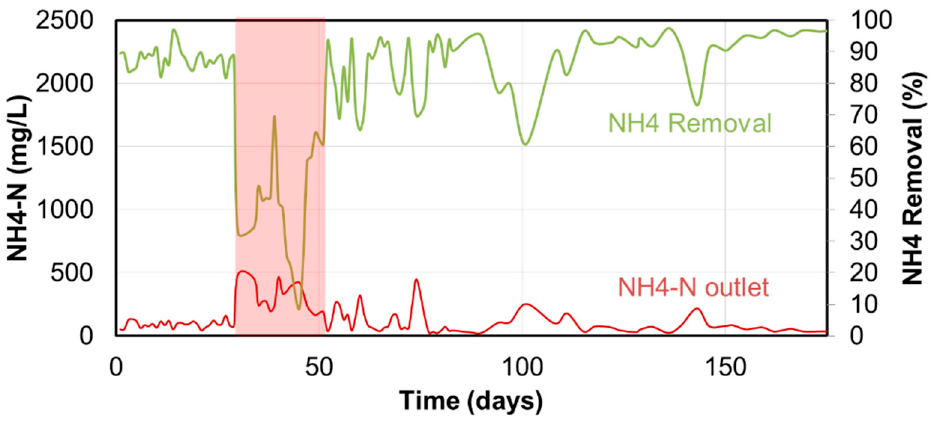
Figure 12. NH 4 -N removal and NH 4 -N outlet concentration of a PN/A ANAMMOX reactor while hypochlorite was accidentally spilled at day 29 and activity was restoring around day 44 and regular loadings treated at day 55.